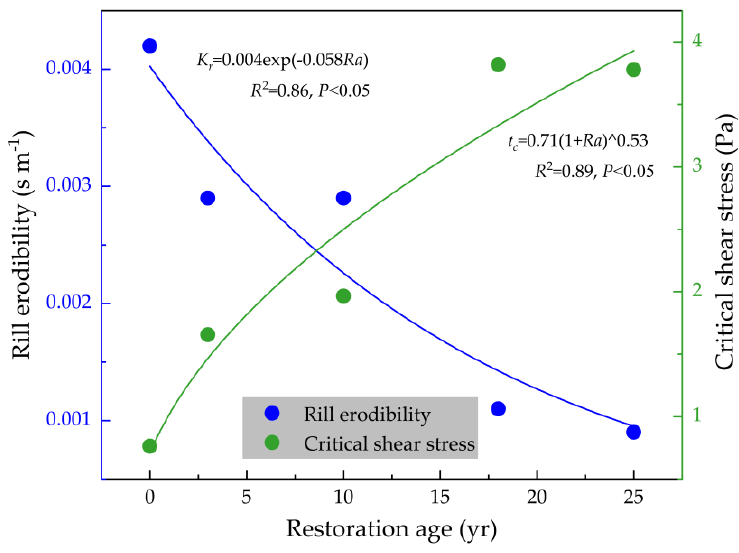
Figure 10. Relationships between soil erodibility and critical shear stress and revegetation age.